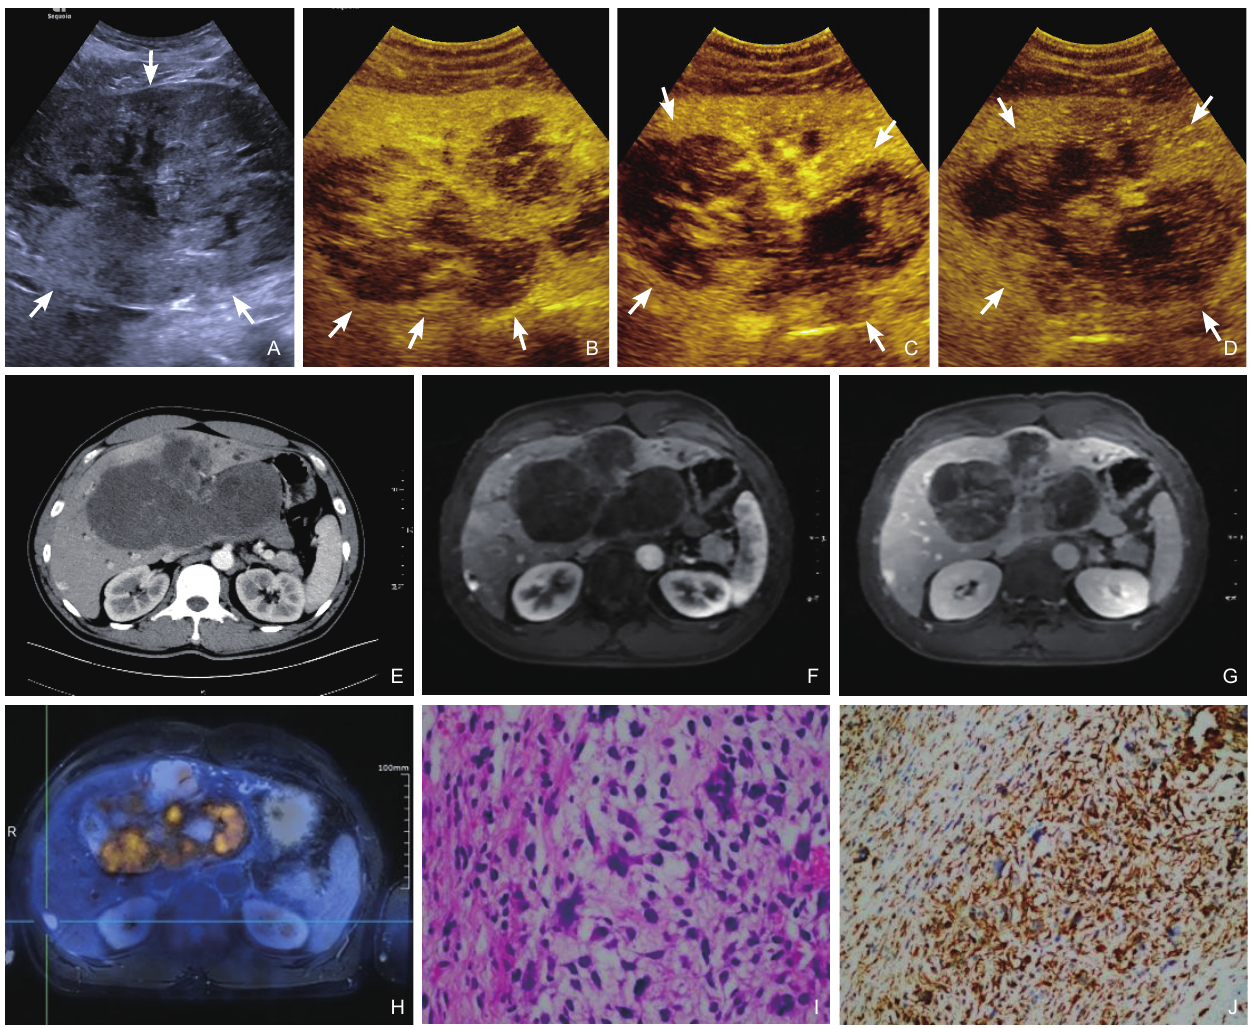
Figure 2 Undifferentiated embryonal sarcoma of the liver (UESL) in a 46-year-old male. (A) The lesion appeared to be a heterogeneously echoic masses on sonography, with scatted anechoic areas; (B-D) On contrast-enhanced ultrasound (CEUS), it exhibited rim hyperenhancement and the enhancement progressed towarded the center during the arterial phase. Mild washout was observed in the portal venous and late phase. Perfusion defection scattered in the nodule during the whole scan; (E) The hypodense mass showed a multilocular cystic appearance. Progressive enhancement was observed in the sepatation within the tumor on contrast-enhanced CT; (F-G) The nodule exhibited delayed enhancement and the enhancement of the mass remained lower comparing with the surrounding parenchyma during the whole process on contrast-enhanced MRI; (H) PET/MRI showed 18F-fluorodeoxyglucose (FDG) uptake in part of the solid components of the cyst, with a maximum standardized uptake value (SUV) of 8.9; (I-J) Histopathological examination showed that the tumor cells were spindle or polygonal-shaped and in fascicular arrangement. (H&E staining; magnification: × 400). Immunohistochemistry analysis showed the tumor was positivity for vimentin (magnification: ×